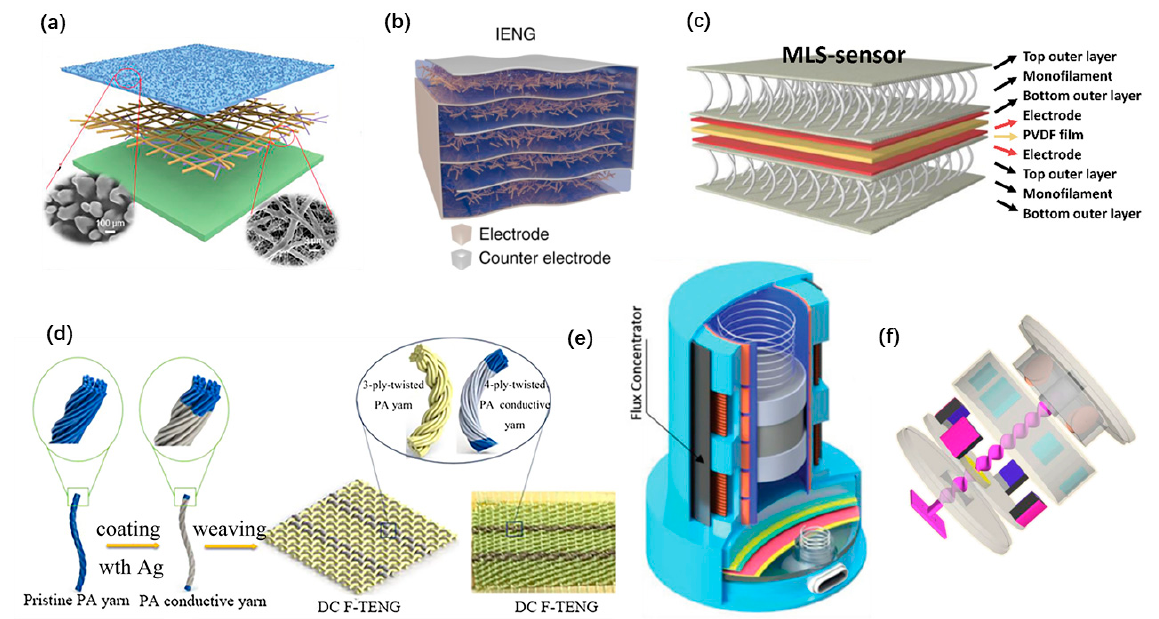
Figure 4. Structures of wearable nanogenerators. ( a ) An ultrathin skin-inspired TENG. Reproduced with permission from Ref. [74]. Copyright © 2020, Wiley-VCH. ( b ) A PENG with a three-dimensional intercalation electrode. Reproduced with permission from Ref. [77]. Copyright © 2020, Springer Nature. ( c ) A 3D textile structured PENG. Reproduced with permission from Ref. [49]. Copyright © 2020, Elsevier. ( d ) A textile TENG. Reproduced with permission from Ref. [81]. Copyright © 2020, American Chemical Society. ( e ) An inertial structured hybrid nanogenerator. Reproduced with permission from Ref. [64]. Copyright © 2020, Wiley-VCH. ( f ) A linear-to-rotary hybrid wearable nanogenerator. Reproduced with permission from Ref. [42]. Copyright © 2020,